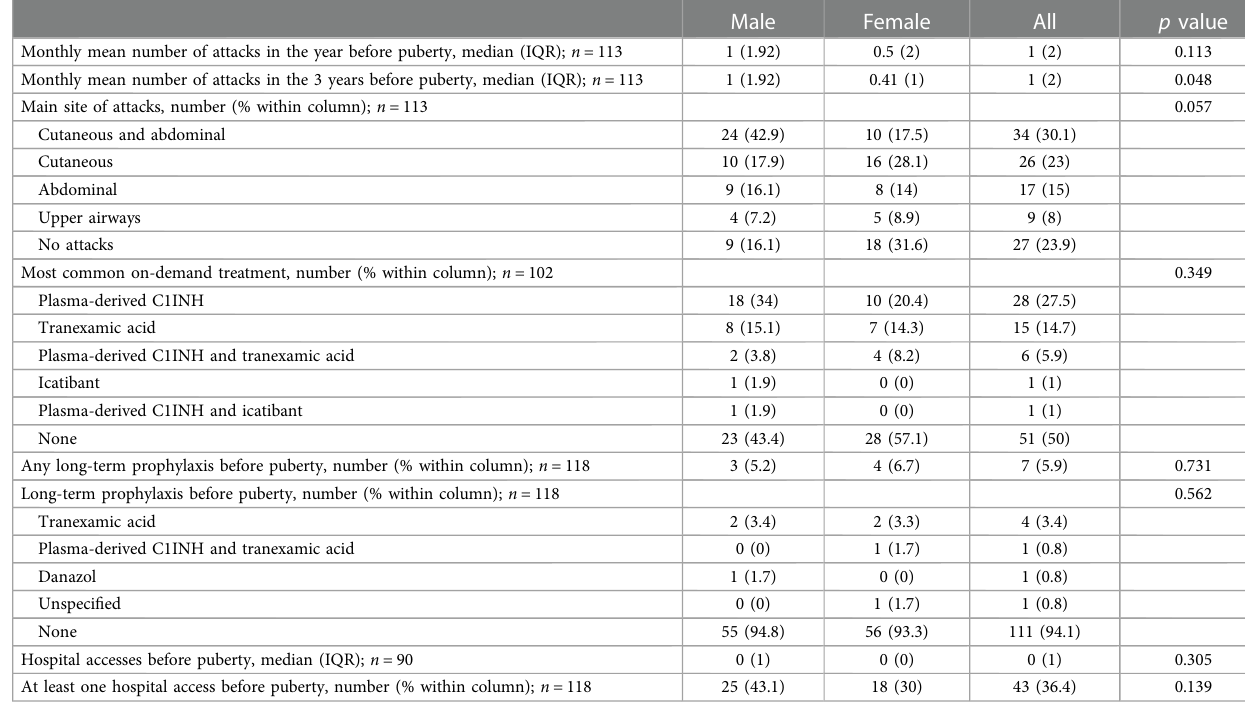
TABLE 2 Angioedema attacks and treatments before puberty among male and female subjects.